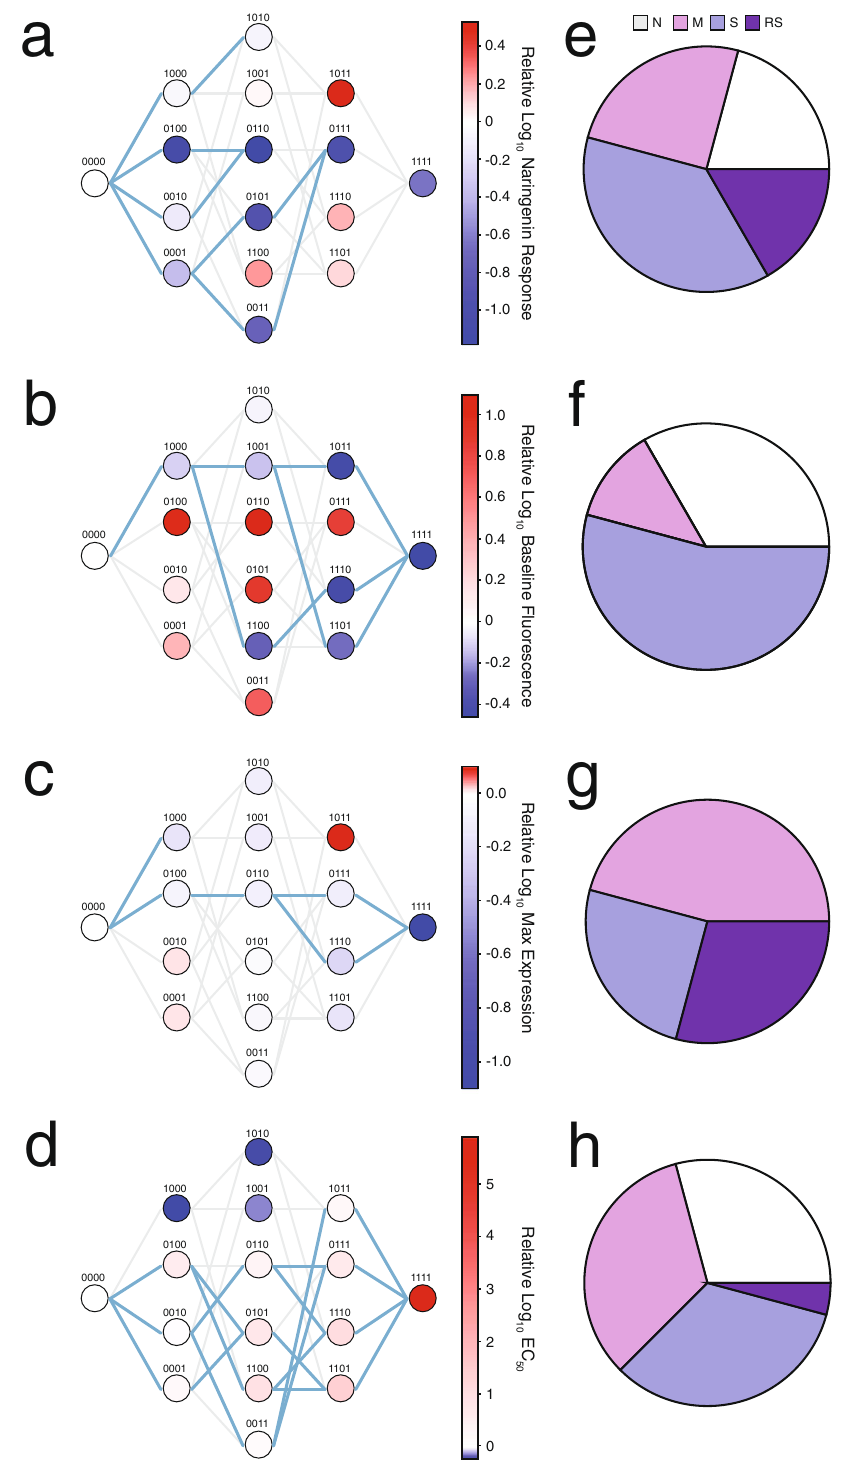
Fig. 3 Fitness landscapes for multiple functional parameters in response to induction with naringenin. Fitness landscapes of ( a ) fold induction, ( b ) basal gene expression, ( c ) maximum gene expression, and ( d ) EC 50 parameters for all 16 TtgR variants in response to naringenin with each variant shown as a node in the graph. The labeling and line colors are analogous to Fig. 2. Nodes are shaded by log 10 of the fi tness parameter at 2000 μ M naringenin normalized to the fi tness of wild type TtgR. Number of epistatic subnetworks in the resveratrol ( e ) fold induction, ( f ) basal gene expression, ( g ) maximum gene expression, and ( h ) EC 50 landscape determined by Bahadur expansion. The labels of the pie charts are identical to Fig.